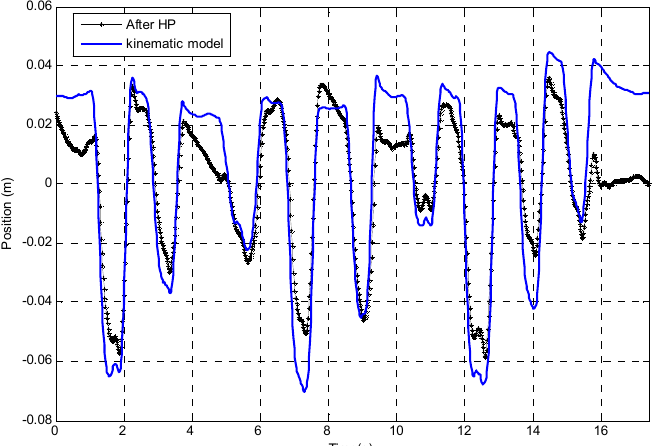
Figure 16. Drift removal by HP filter compared with kinematic model tracking result.